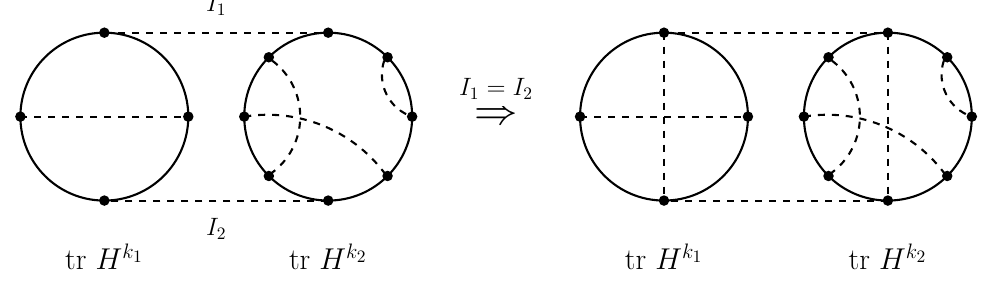
Figure 2 . An example of a diagram contributing to the double trace with k 1 = 4 and k 2 = 8